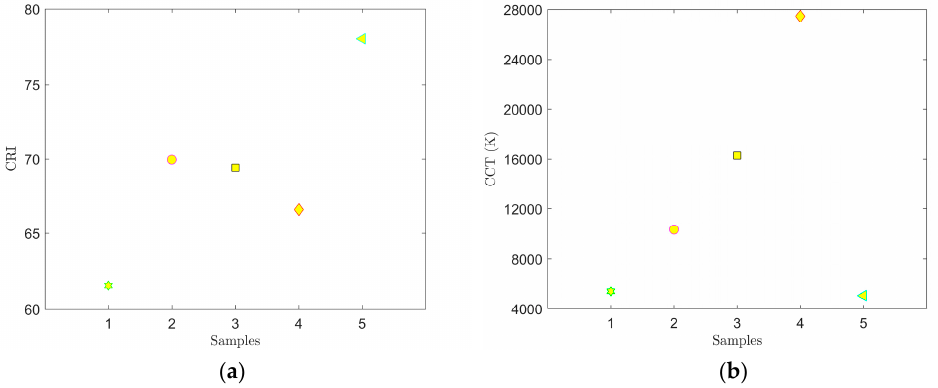
Figure 10. Location of samples 1–5 in the CIE 1931 color diagram ( a ), and spectra of samples 1–5 ( b ).